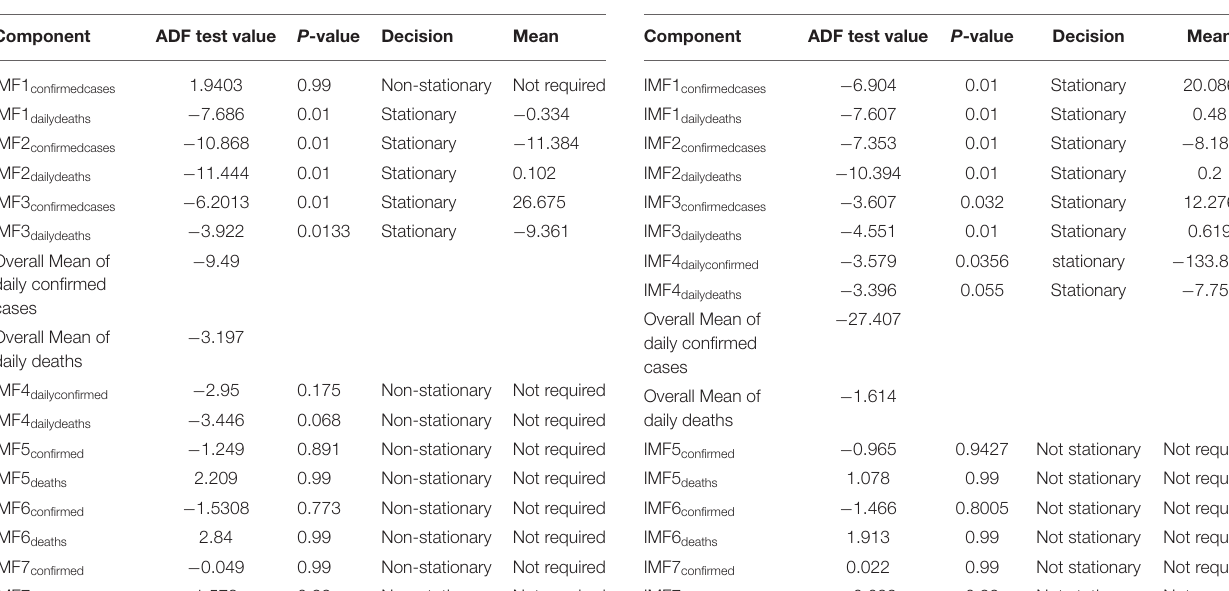
TABLE 3 | ADF test results along with the overall mean for Germany.